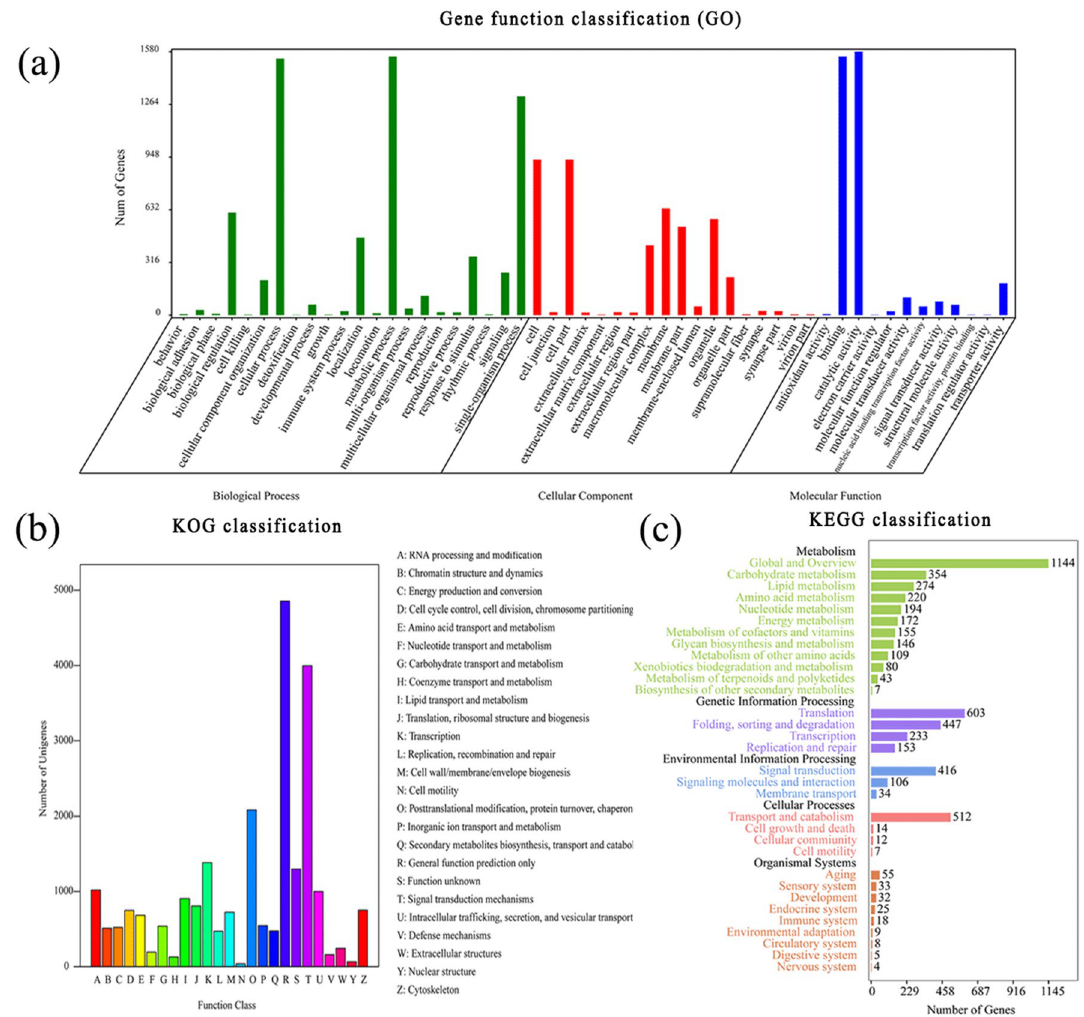
Figure 1. Distribution of transcriptome contigs from Quadrastichus mendeli adults. ( a ) Gene Ontology (GO) analysis. ( b ) Eukaryotic Orthologous Groups of protein (KOG) classification. ( c ) Kyoto Encyclopedia of Genes and Genomes (KEGG) classification. (n =